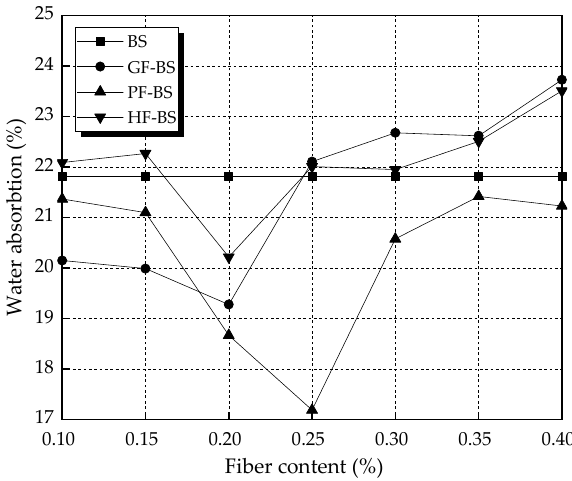
Figure 6. Water absorption of the specimens.